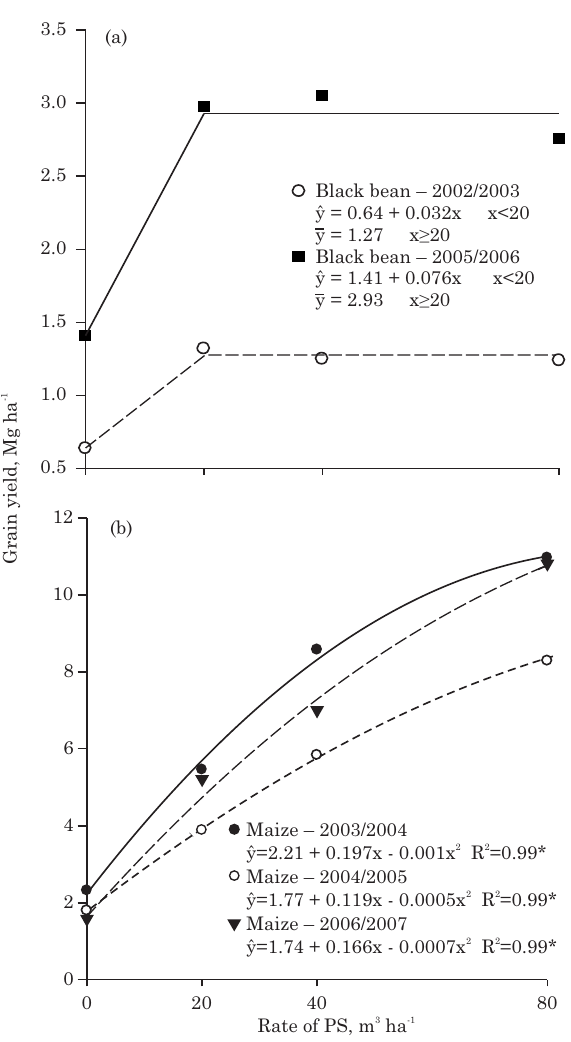
Figure 2. Grain yield of black bean (a) and maize (b) fertilized with 0, 20, 40 and 80 m 3 ha -1 pig slurry (PS) in different growing seasons. * indicates that the coefficients of determination were significant by the F test at